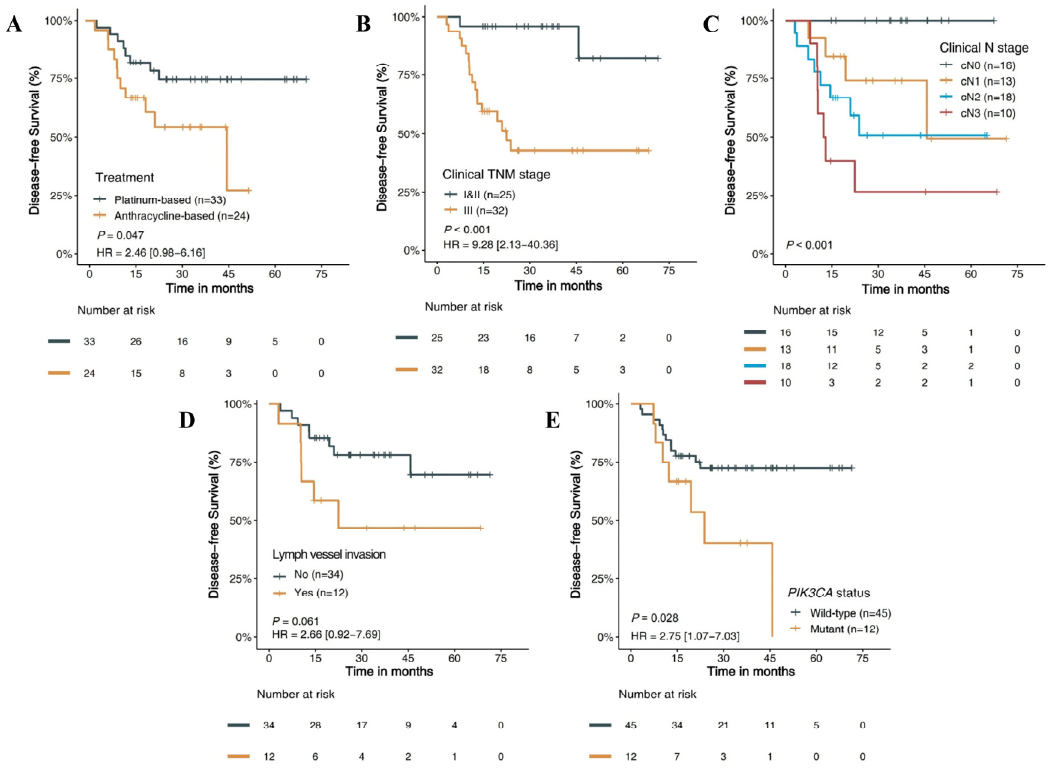
Figure 3. Kaplan–Meier survival curves for DFS of patients with non-pCR TNBC. DFS based on ( A ) NAC regimens; ( B ) clinical TNM stage; ( C ) clinical N stage; ( D ) lymph vessel invasion; ( E ) PIK3CA status. DFS, disease-free survival; pCR, pathologic complete response; TNBC, triple-negative breast cancer; NAC, neoadjuvant chemotherapy; cTNM, clinical TNM stage; cN, clinical N stage; HR, hazard ratio.